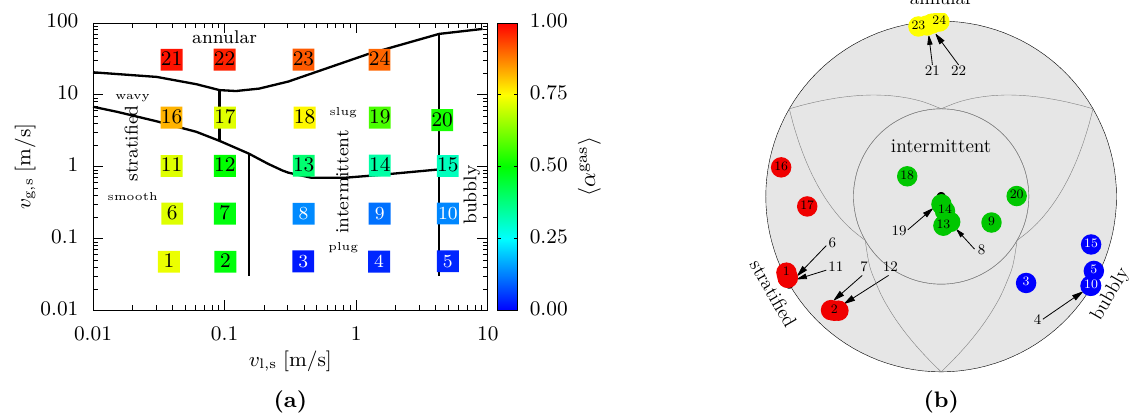
Figure 8. Comparison of measurement results from indWMS against Mandhane’s [29] flow pattern map for horizontal pipe orientation: ( a ) cross-sectionally averaged gas fraction; ( b ) flow pattern in terms of polar coordinates according to [24] (color indicates most dominant